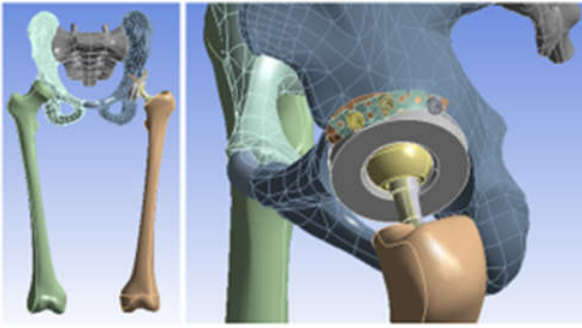
Figure 44. The analysed model loaded in Ansys Workbench.